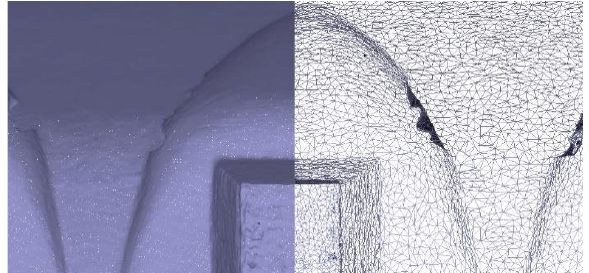
Figure 5. Comparison between the high-poly mesh (on the left) and the decimated one (on the right). Detail of a